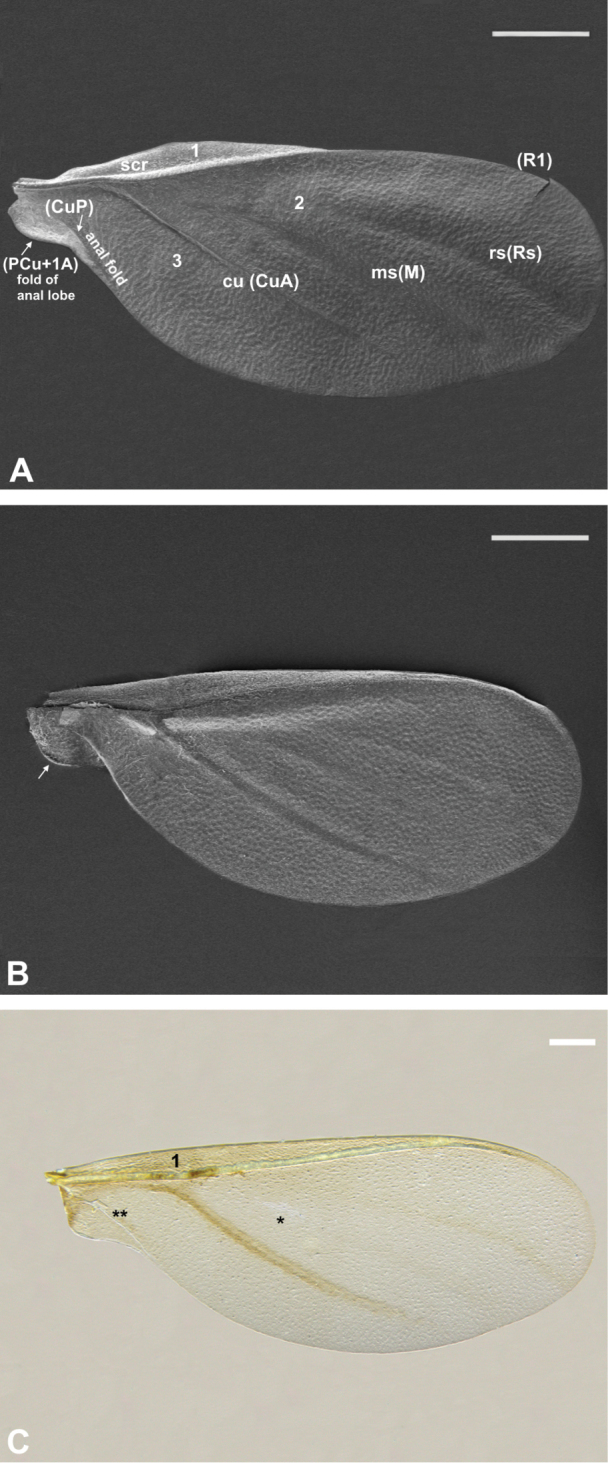
Forewing of Orthezia
urticae (Linnaeus, 1758) A dorsal view under SEM B ventral view under SEM; Scale bar: 50 µm C dorsal view under LM; Scale bar: 250 µm; vein names without brackets after Koteja (1986), with brackets after Shcherbakov (2007); other symbols explained in the manuscript.